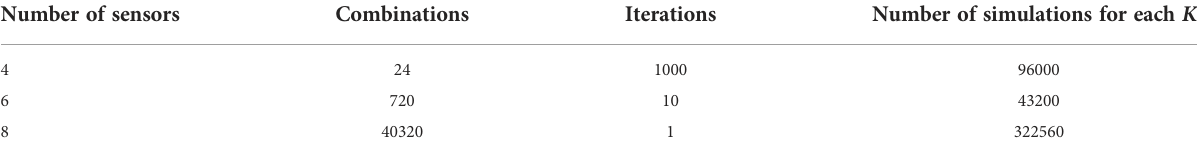
TABLE 3 Number of Monte Carlo simulations for different number of sensors. Number of